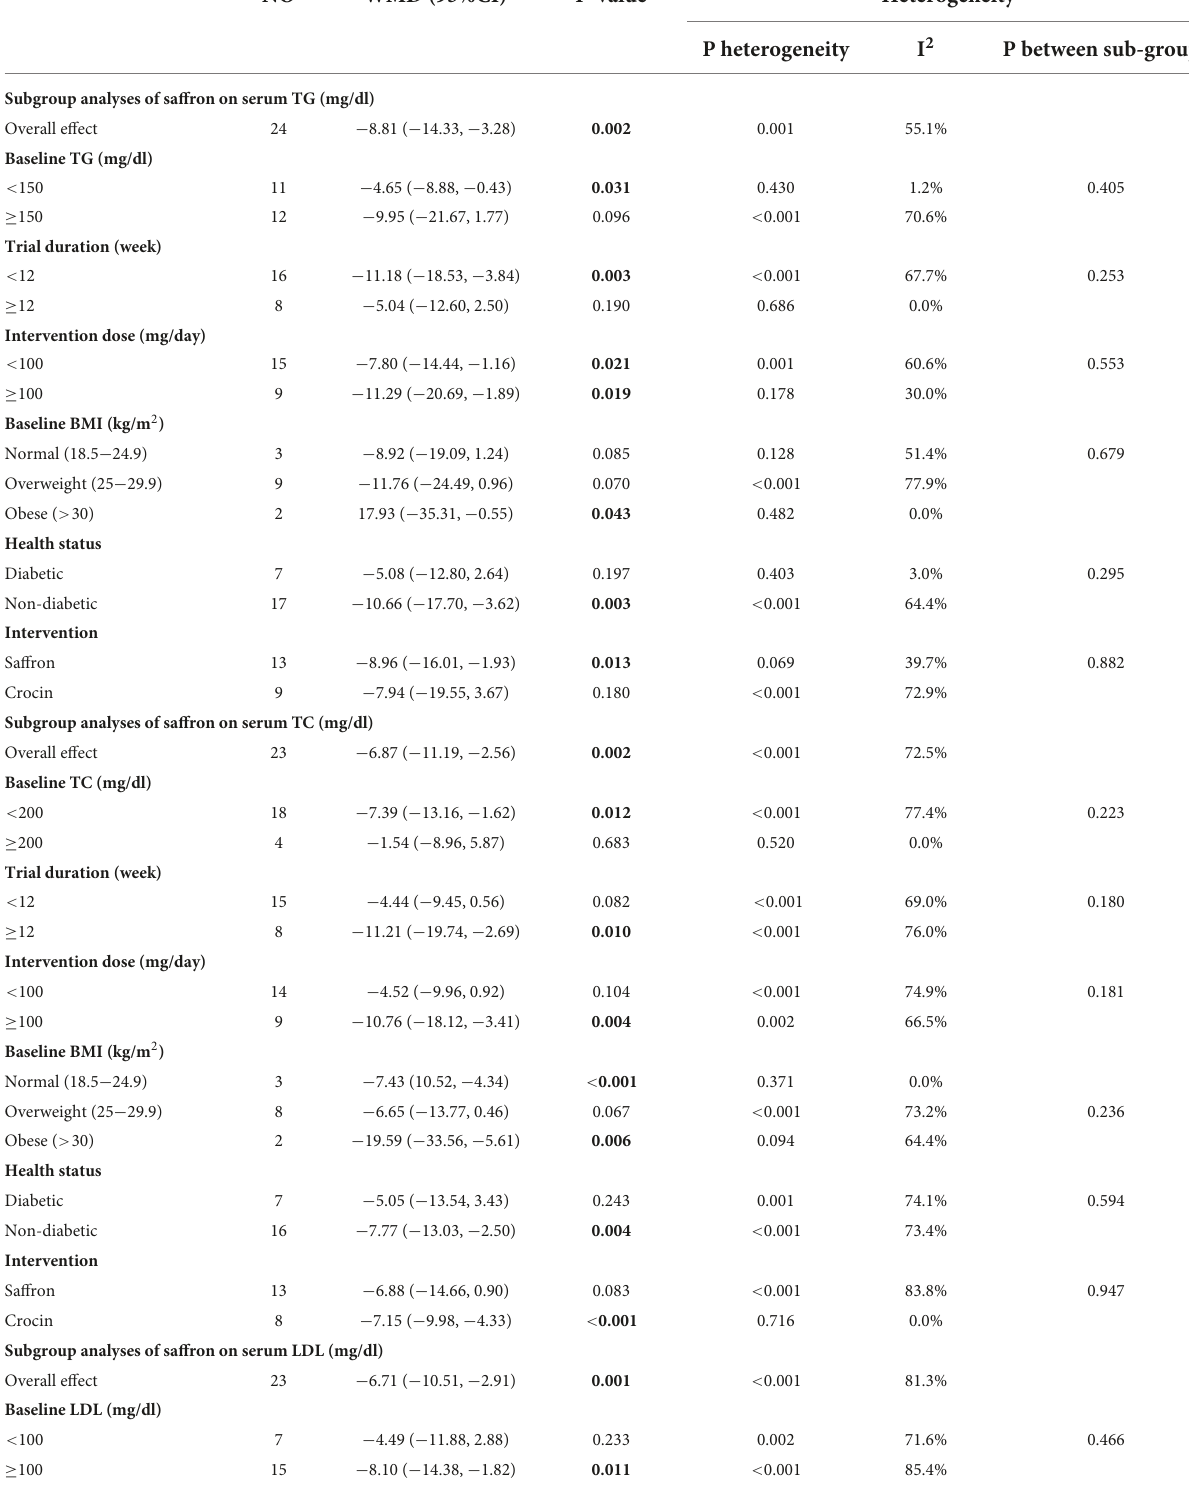
TABLE 3 Subgroup analyses of saffron on CVD risk factors in adults. NO WMD (95%CI) P -value Heterogeneity P